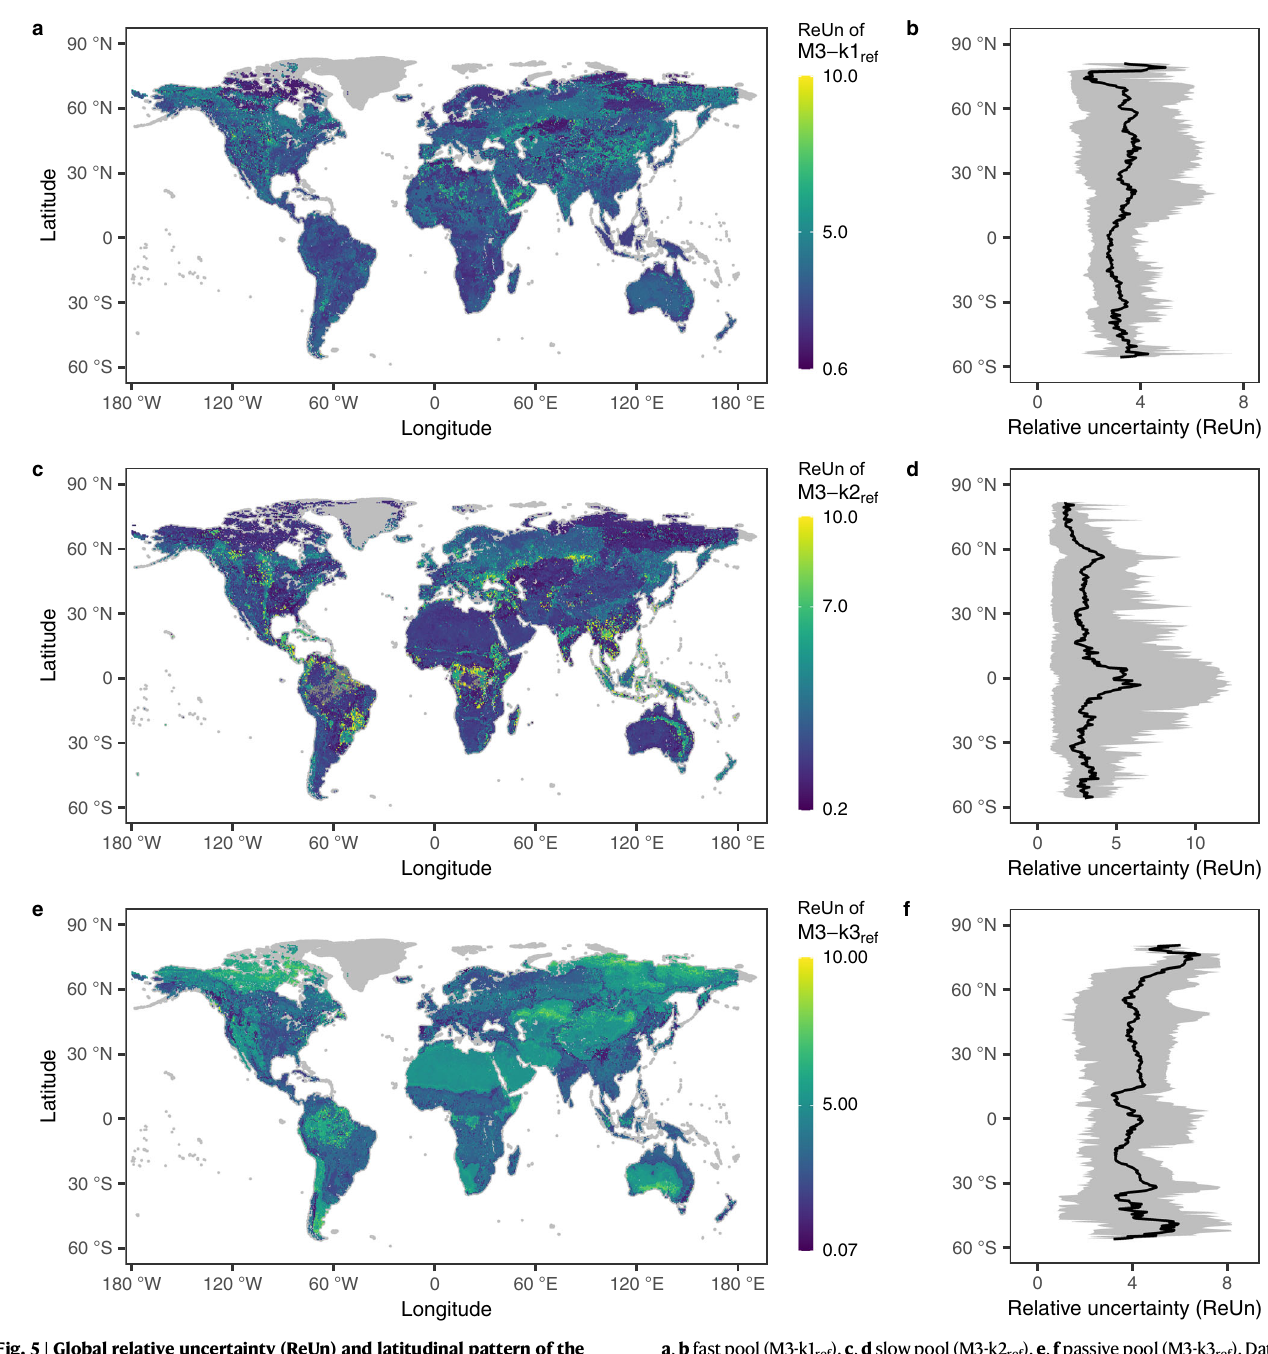
Fig. 5 | Global relative uncertainty (ReUn) and latitudinal pattern of the reference decomposition rates (k ref ) of the three soil organic matter (SOM) pools predicted by the Random Forest (RF) model with feature selection.